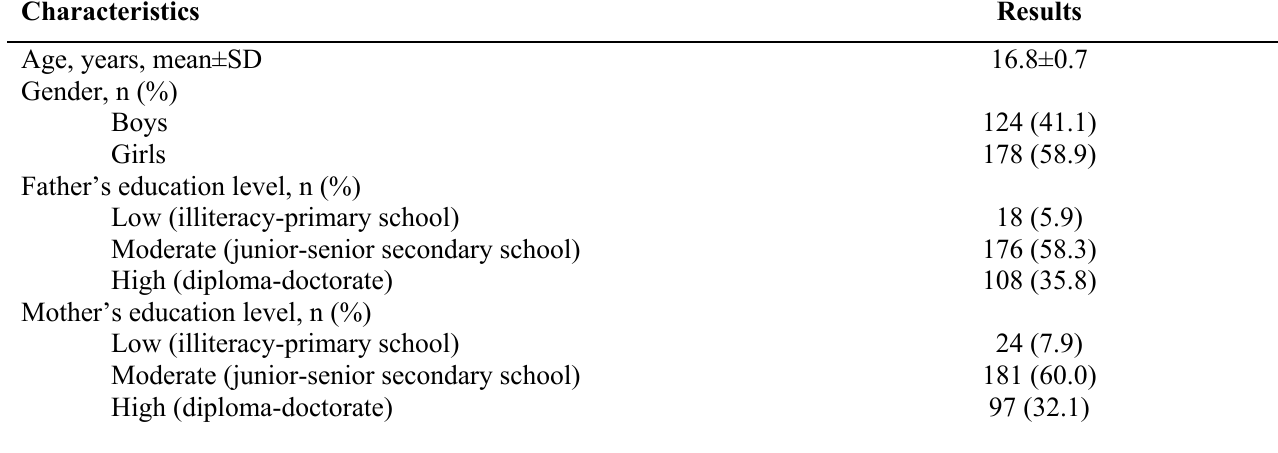
Table 2. Characteristics of the subjects